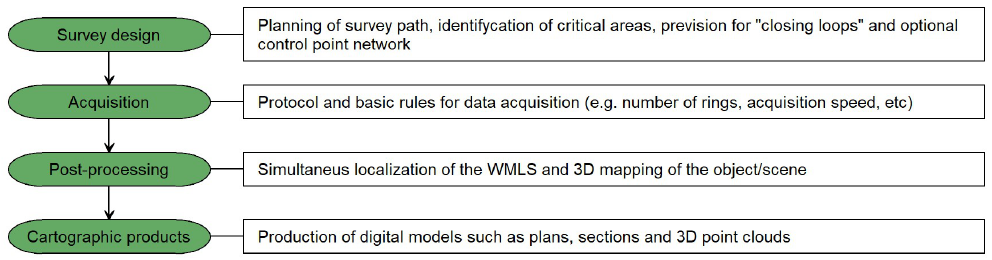
Figure 2. Methodological phases of the procedural pipeline for surveys with a WMLS.